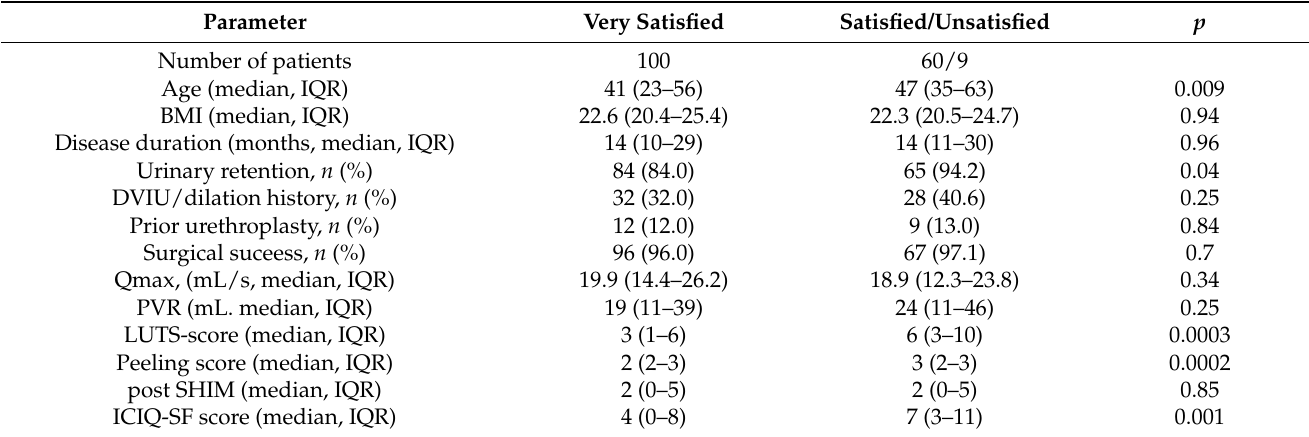
Table 8. Association between satisfaction and parameters.